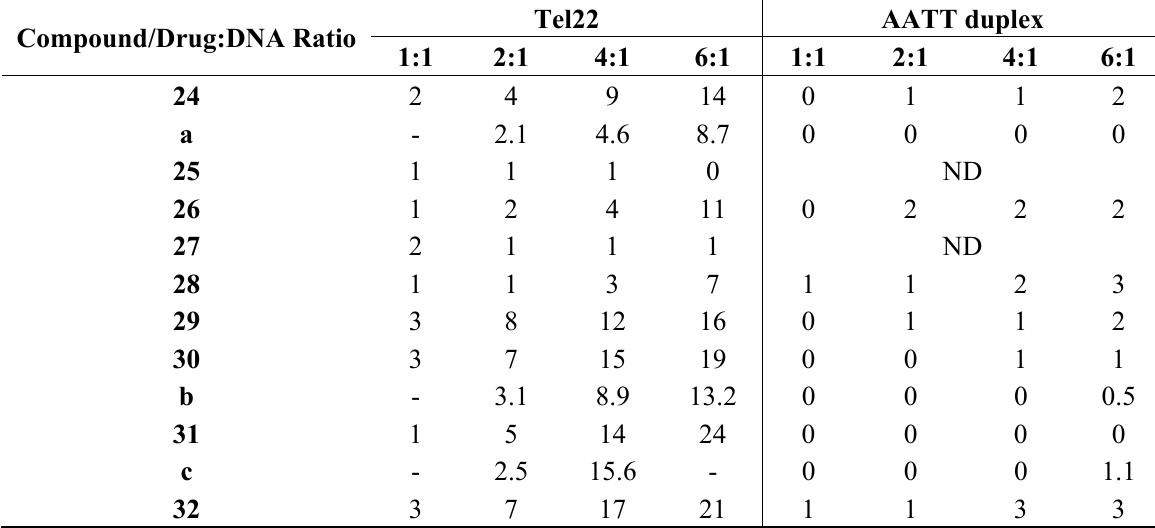
changes of trimethine cyanine analogs with telomeric quadruplex (Tel22) and Table 1. T m a control duplex